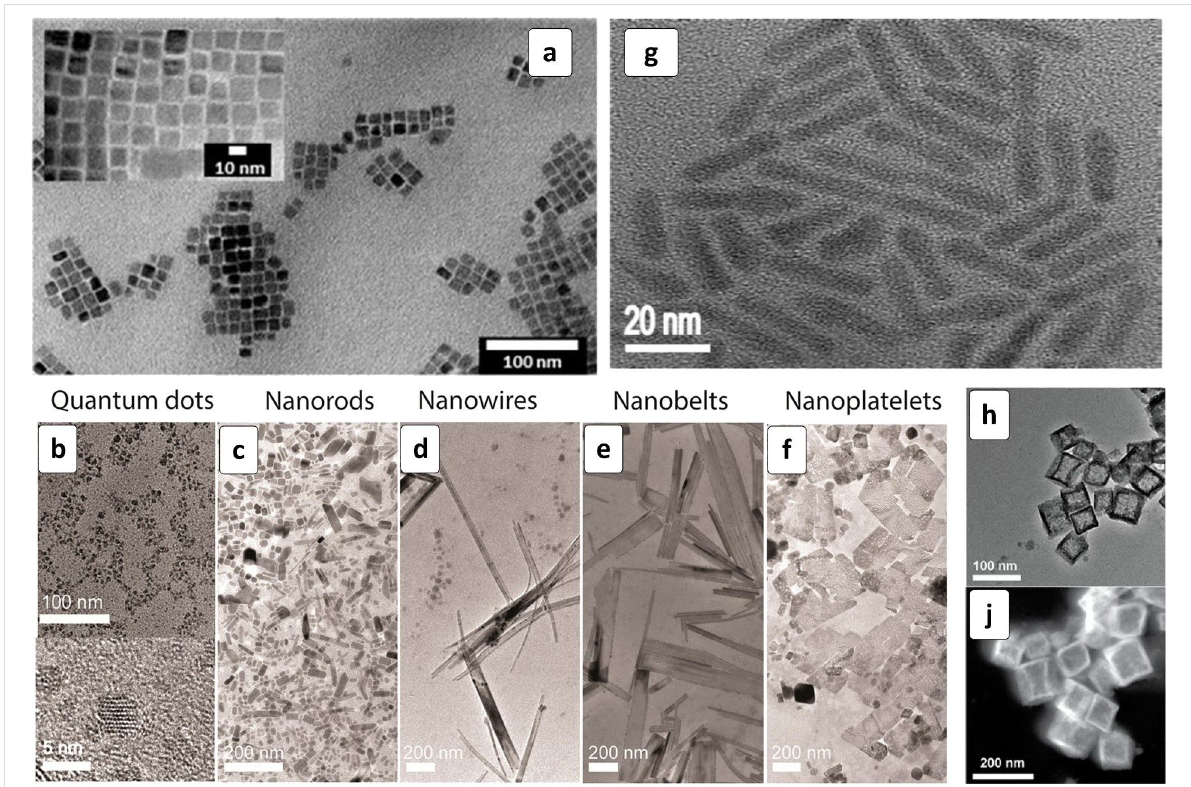
Figure 7: TEM (a–h) and STEM (j) images of CsSnI 3 nanocrystals (NCs): (a) Cs 2 SnI 6 in the form of NCs (b), nanorods (c,g), nanowires (d), nanobelts (e), and nanoplatelets (f); CsSnBr 3 nanocages (h,j). (a) Reproduced with permission from [131], copyright 2016 American Chemical Society; (b–f) Reprinted and adapted with permission from [133], copyright 2016 American Chemical Society; (g) Reprinted and adapted with permission from [72], copyright 2016 American Chemical Society and (h,j) Reprinted and adapted with permission from [135], copyright 2017 American Chemical